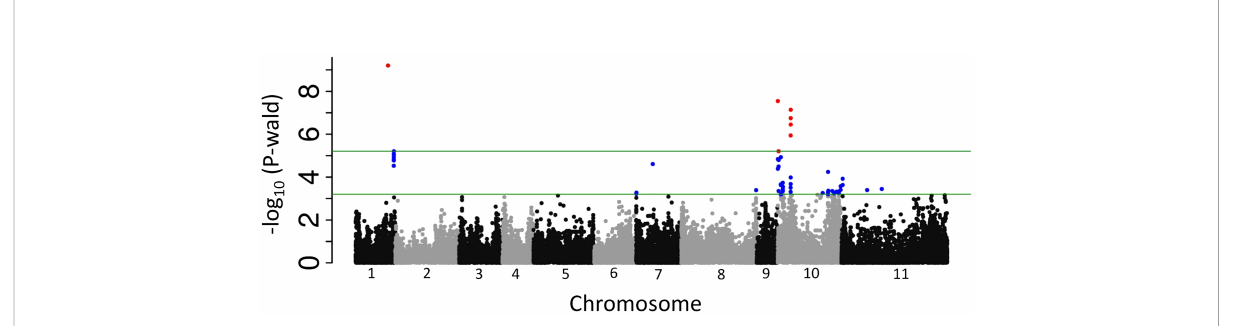
FIGURE 1 Manhattan plot of anthracnose resistance to race 73. The upper horizontal bar represents the cutoff for the most 0.01% signi fi cant single- nucleotide polymorphisms (SNP) (depicted in red). The lower horizontal bar represents the cutoff for the 0.1% signi fi cant SNP (depicted in blue). Both cutoffs are based on 1,000 bootstraps of the empirical distribution of the p-values.